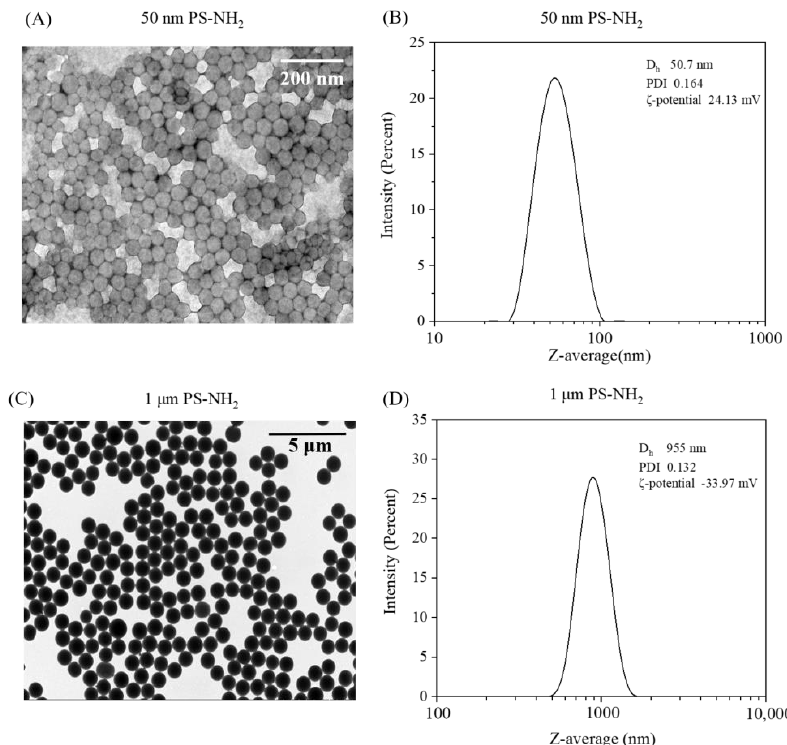
Figure 1. TEM images ( A , C ) and DLS measurements ( B , D ) of PS-NH 2 MNPs in ultrapure water. Dh, PDI, and ζ-potential represent hydrodynamic diameter (nm), polydispersity index (PDI), and zeta potential (mV), respectively.